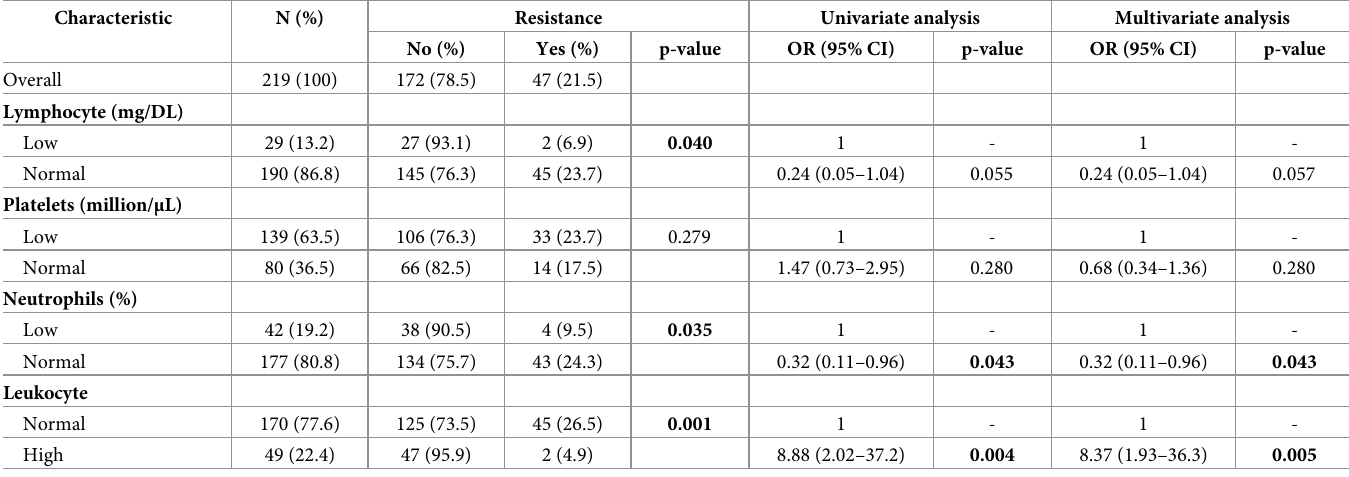
Table 3. Leukogram and resistance to antimalarial